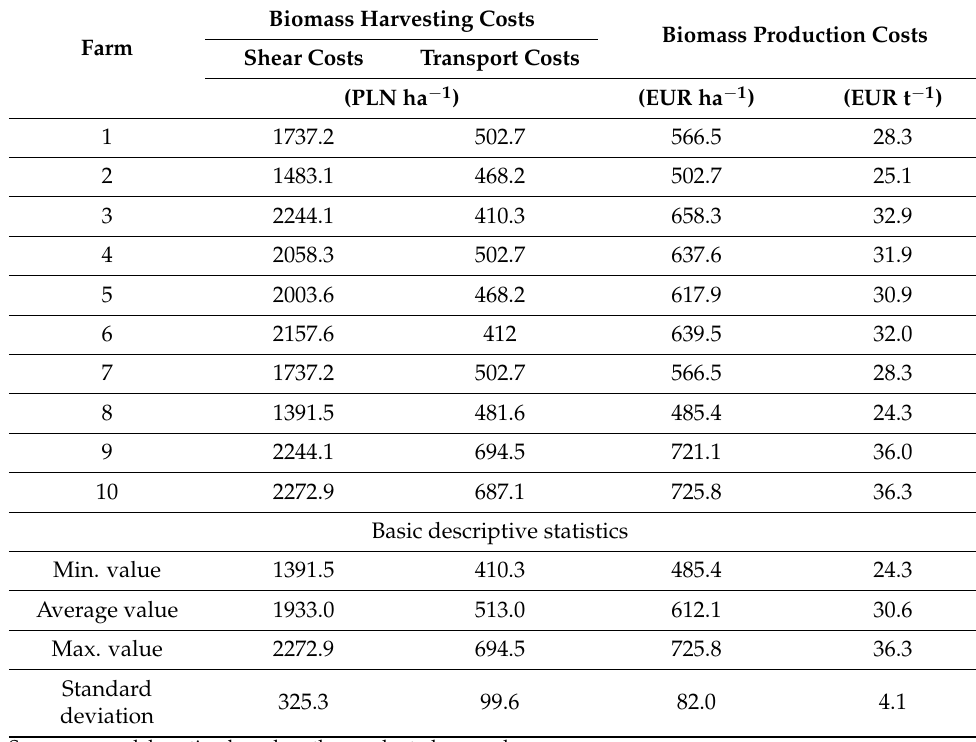
Table 9. Production costs of biomass from energy willow.